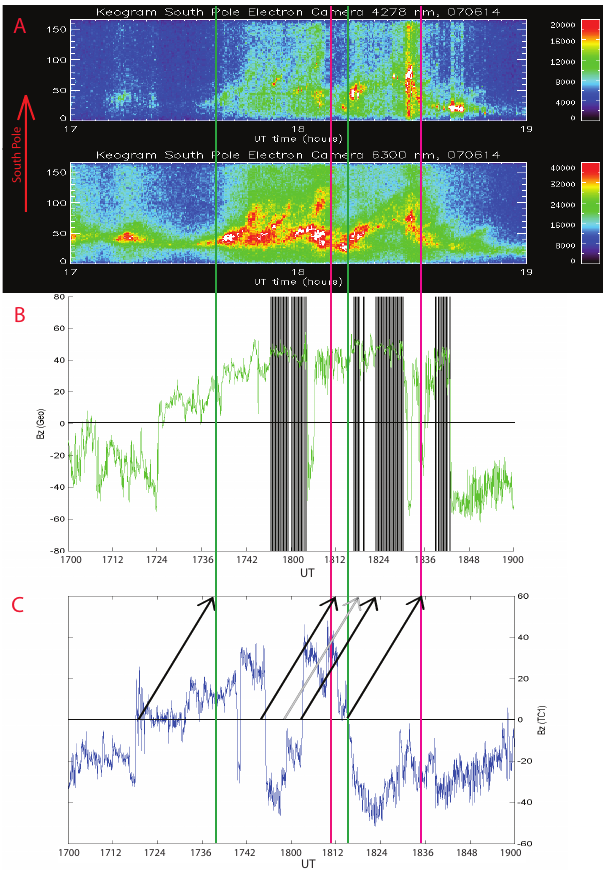
Fig. 7. A schematic showing the behaviour of the magnetopause (solid curved line) and aurora (green slinky) after northward and southward turing of the IMF. Top: the magnetosphere is compressed and both TC1 and Geotail are in the magnetosheath. Middle: after the northward turning the magnetopause expands (from dashed to solid curve) and Geotail moves into the magnetosphere. The au- rora moves poleward at the same time. Bottom: after the IMF turns southward, the magnetosphere is eroded again and the magne- topause moves inward again and Geotail exits the magnetosphere. The aurora moves equatorward